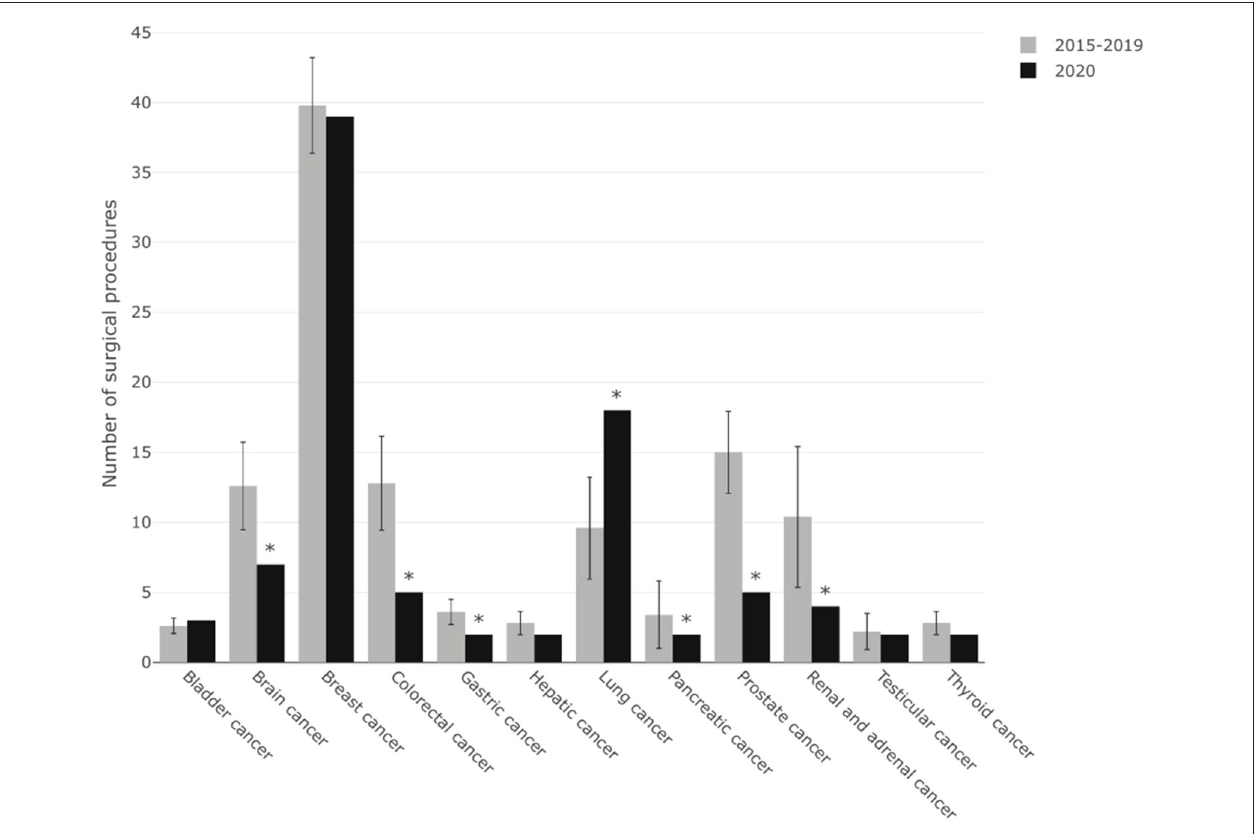
FIGURE 2 | Shown is the number of oncologic surgeries for major oncologic entities performed during the 2020 observation period compared with the same period in